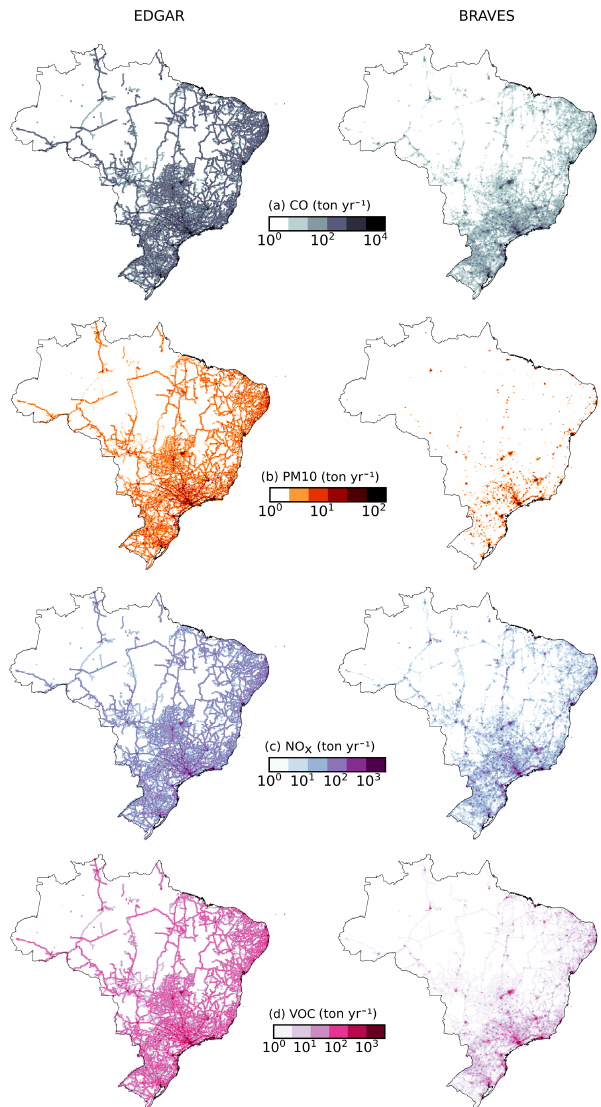
Figure 8. Comparison of (a) CO, (b) PM 10 , (c) NO x , and (d) VOC spatial distribution (log scale) provided by the EDGAR and BRAVES